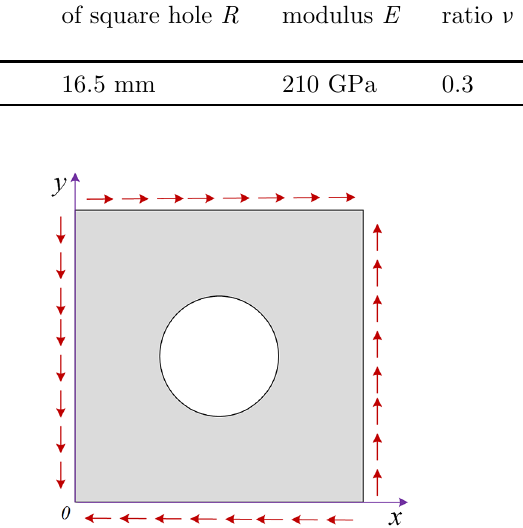
Fig. 1. Dimensional parameters of the perforated plate on the side. Table 1. Geometric dimensions and material properties of the perforated plate. Parameter